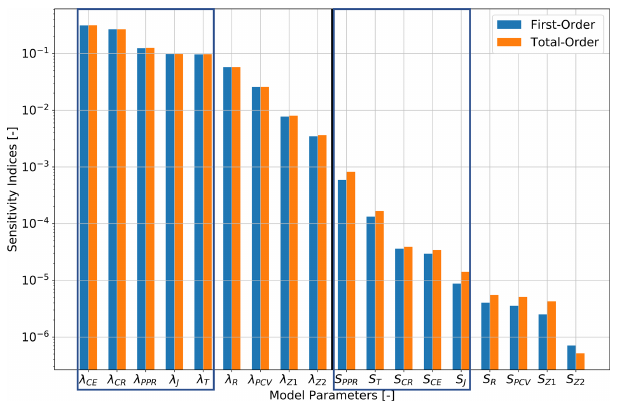
Figure 2. Global sensitivity indices for the analysis focusing on the sedimentary layers of the CEBS. The first-order indices are denoted in blue and the total-order indices in orange. Furthermore, we mark the parameters used in further analysis with blue rectangles, and the vertical black line denotes the separation between the thermal conductivities and radiogenic heat production. For the acronyms, please refer to Table